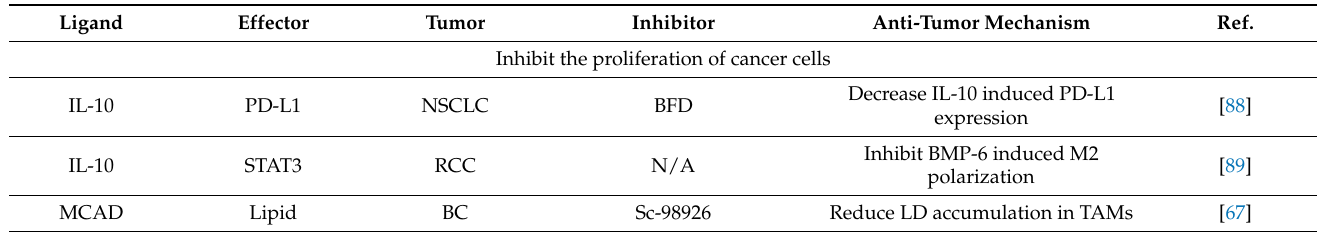
Table 2. Targeting proteins in the crosstalk between TAMs and cancer